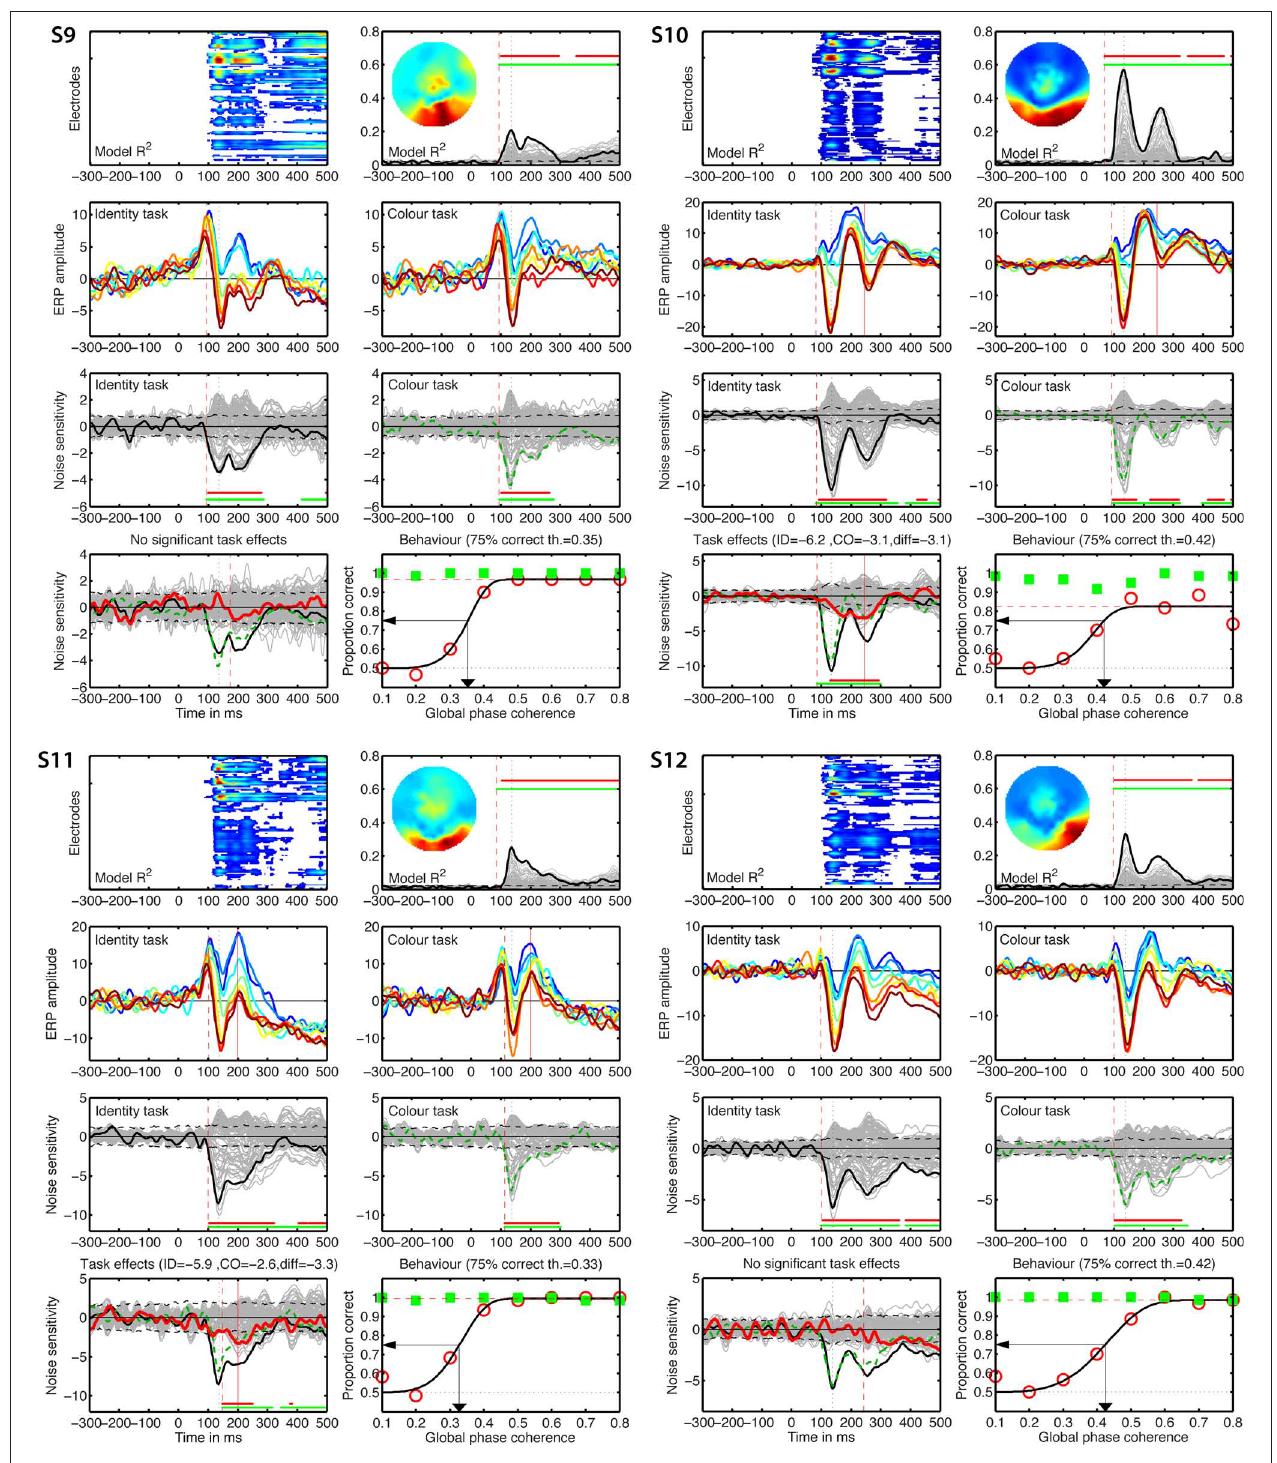
FiGuRE 7 | individual results for subjects S 9– S 12. See Figure 5 caption for details.